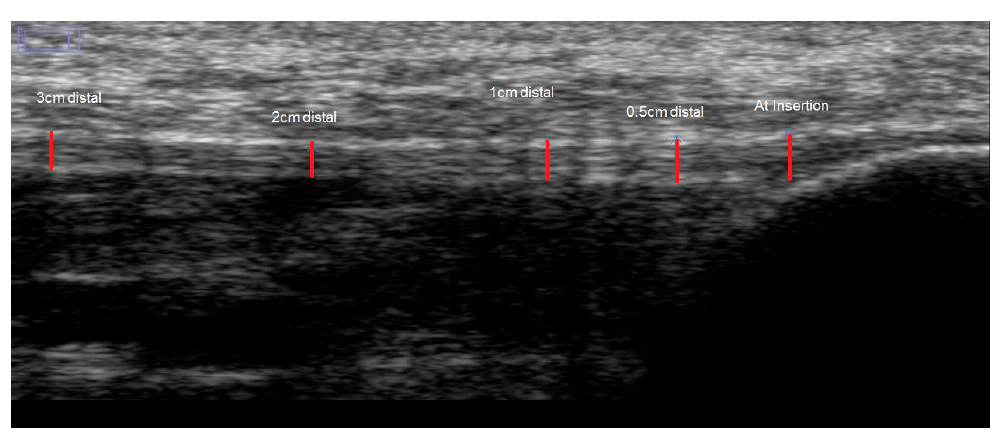
Figure 2. Sonograph showing measurement of plantar fascia (PF) thickness at five various points: its insertion at medial calcaneal tubercle; 0.5, 1, 2 and 3 cm distal, with red lines showing caliper positioning for analysis and measurements.